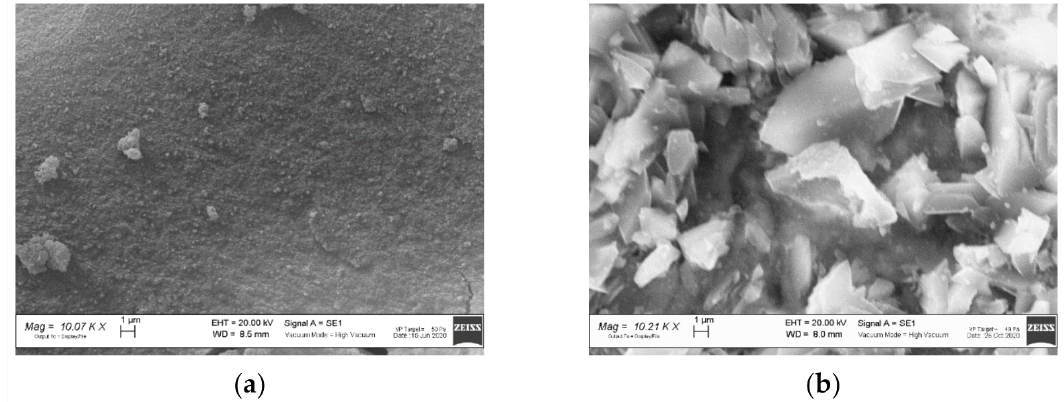
Figure 8. SEM images of the ZIF-8 samples: ( a ) As-synthesized and ( b ) after OFL adsorption at pH 8.1.